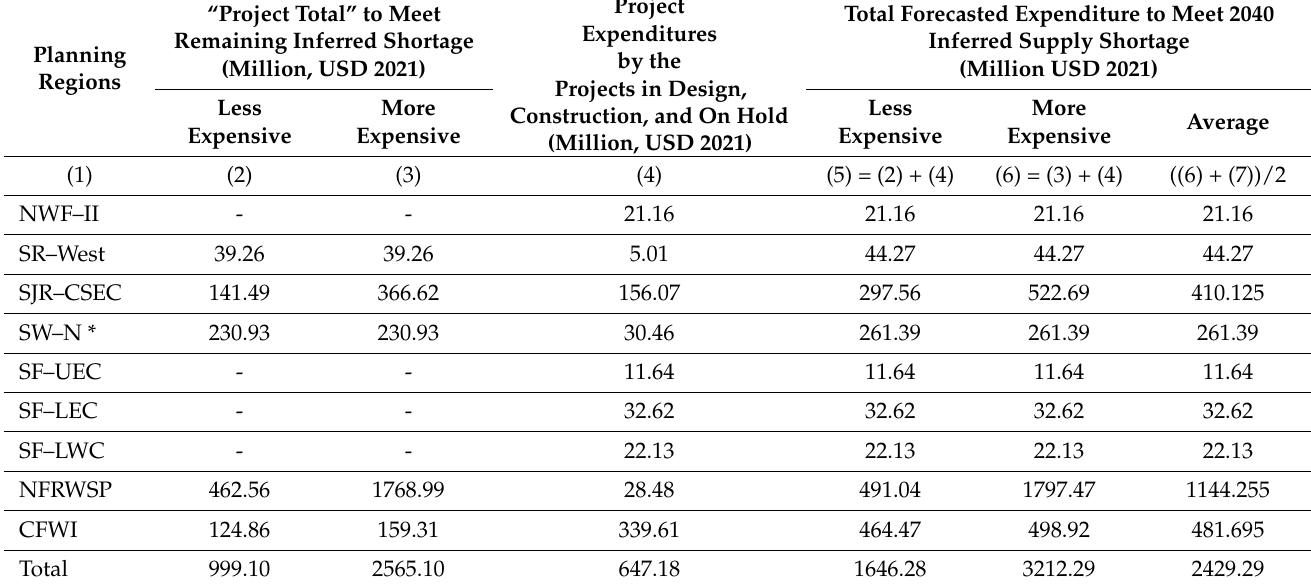
Table 6. Projected Expenditures for the Additional Water Supply using Chebyshev’s inequality Bounds Project Expenditures.